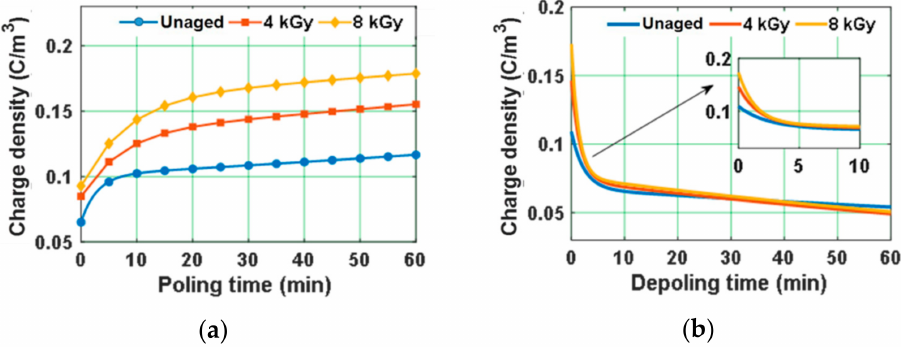
Figure 8. Average space charge density of unaged and gamma irradiated samples during ( a ) poling time and ( b ) depoling time